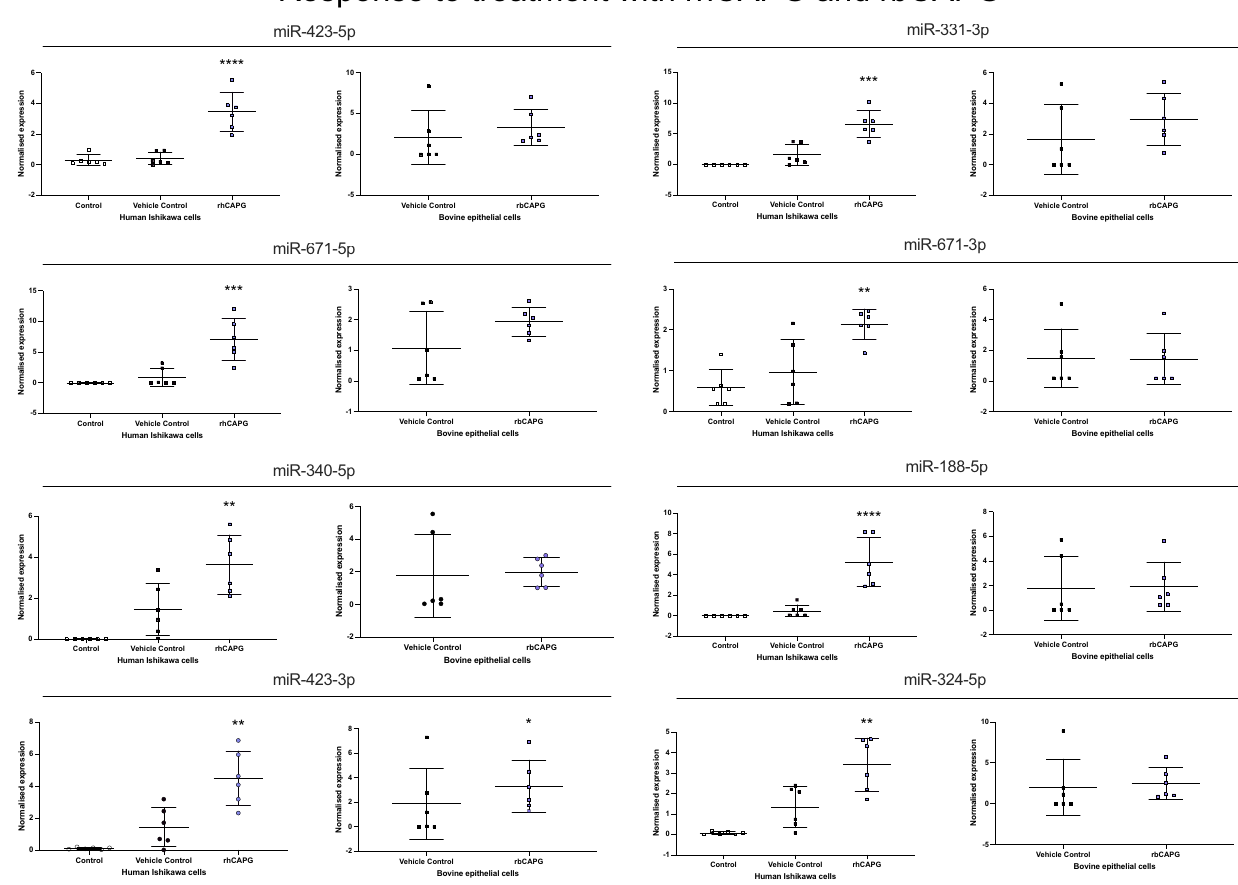
Fig. 3 Regulation of stem lineage miRNAs in human and bovine endometrial epithelial cells treated with hCAPG or bCAPG respectively. Expression of stem lineage miRNAs miR-432-5p, miR331-3p, miR-671-5p, miR-671-3p, miR-340-5p, miR-188-5p, miR432-3p and miR-324-5p in either human (left-hand side of each pair) or bovine (right-hand side of each pair) endometrial epithelial cells ( n = 6 per treatment). Primary bovine endometrial epithelial cells were treated with vehicle control (grey circle), or 1000ng/ μ L bCAPG (purple circle) for 24 h. Human Ishikawa immortalised endometrial epithelial cells were treated with control (open circle), vehicle control (closed circle), or 1000ng/ μ L hCAPG (purple circle) for 24 h. Signi fi cant differences in miRNA expression values determined when p ≤ 0.05 are depicted by an asterisk Sequence conservation analysis between human and cow PDI and CAPG and their interacting partners . The level of sequence similarity between human and cow PDI and CAPG have been published previously 37 . (Note: PDI refers to the protein product of gene P4HB, PDI is a conceptus-derived protein 38 .) The inter- acting partners of PDI and CAPG were determined from the String network for these proteins and the human and cow orthologs were assessed for levels of sequence similarity (Table S4). Single Gene Ortholog annotation, alignment, and fi ltering for selective pressure analysis . We chose a total of 10 eutheria that demonstrate the greatest range of diversity in implantation strategy and placental morphology, plus four outgroup species one from each of the following groups: Monotremata , Marsu- pialia , Aves and Teleostei (Table S2). Annotated gene families were taken from Ensembl 90 (accessed 28 November 2017) 25 . A total of 7614 homologous gene families were present in all 14 species (10 placental mammals and 4 outgroups), this included paralogs. From these 7614 homologous gene families, we identi fi ed 1437 gene families that are in a single copy in the eutheria — i.e. single gene orthologs (SGOs often referred to as one-to-one orthologs), had ≥ 7 species 54 and contained at least one suitable (non-eutherian) outgroup. Multiple sequence alignments (MSAs) were generated using MUSCLE v3.8.1551 55 and MAFFT v7.310 56 default settings and the output was compared using the ‘ metal_compare ’ function in VESPA 57 – 59 . The optimal MSA for each SGO was used for selective pressure analysis using codeml from the PAML package 60 wrapped in the VESPA 59 pipeline. The resolved mammal phylogeny 47,48 was appropriately pruned for each of the 1437 SGOs using VESPA so that only those species in the alignment were in the corresponding tree for a given gene family 59 . Aligned amino acids were used in combination with the corresponding nucleotide data to generate aligned nucleotide fi les 59 . Aldrich, UK.